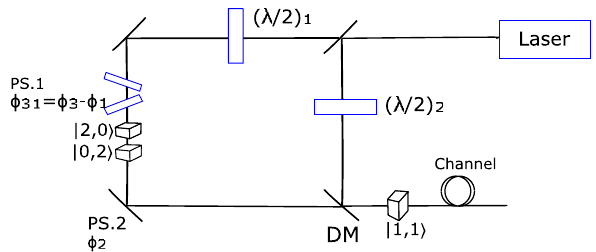
Figure 1. Mach–Zehnder interferometer set up used by Alice and Bob for biphoton state preparation. The laser beam is pumped towards a non-symmetric beam-splitter that transmits 2/3 and reflects 1/3 of the beam through the long and short arms. The ( (cid:31) / 2 ) i represents the halve wave plates for manipulating the amplitude, c i of the states. The phase shifters (PS. 1 and PS. 2) introduce relative phases between the states. The DM denotes the dichroic mirror, which transmits two biphotons created using type I non-linear crystals from the long arm of the interferometer and reflect the pump from the short arm towards the type II non-linear crystal for the creation of 1, 1 state | �